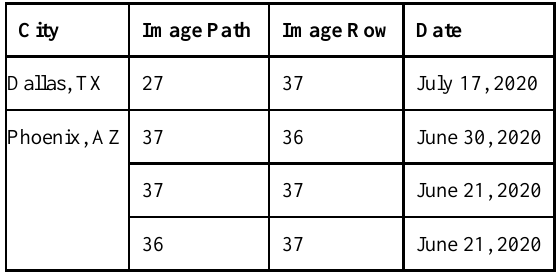
Table 3. Landsat 8 OLI/TIRS images used in study